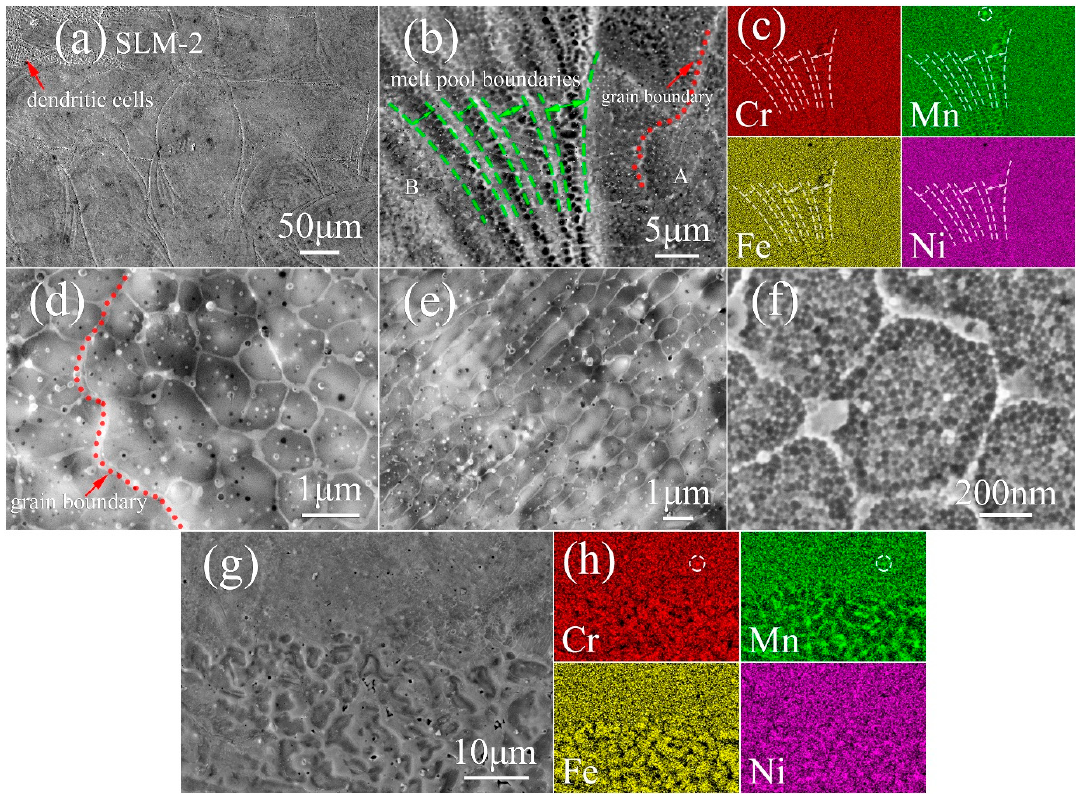
Figure 4. SEM observation on the XY-plane of SLM-2 CrFeNiMn alloy. The SE images of ( a ) melt pool tracks and dendrites; ( b ) detailed microstructure with ( c ) the corresponding quantitative SEM-EDS maps of elemental distribution; ( d ) equiaxed cells; ( e ) elongated cells; ( f ) ultrafine sub-cells; and ( g ) magnified dendritic cells with ( h ) the corresponding quantitative SEM-EDS maps of elemental distribution. The micrographs in ( d , e ) present the typical magnified morphology of area A and B in ( b ),